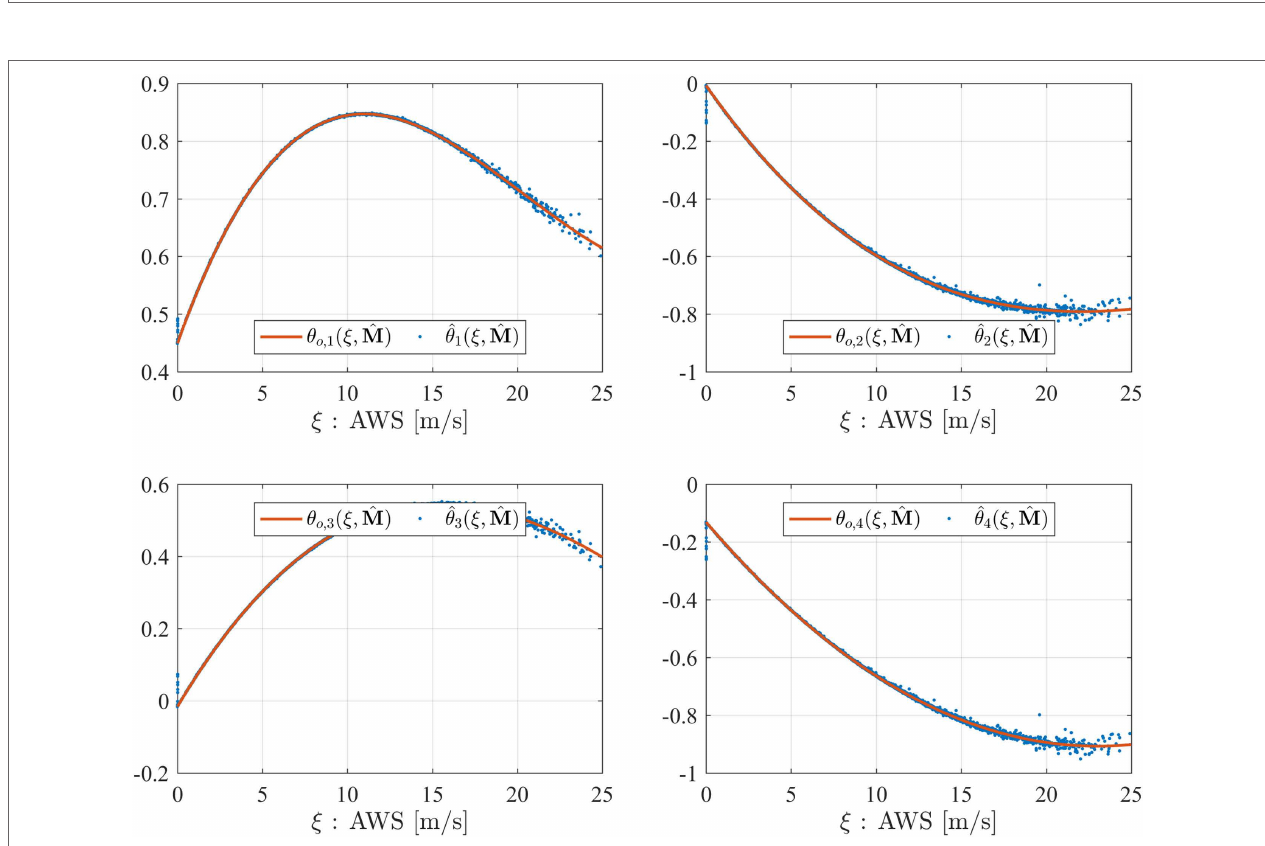
FIGURE 5 | Prior and posterior estimates of the first four parameters of the GP-AR(72) p =4 model for the average wind speed range from 0 to